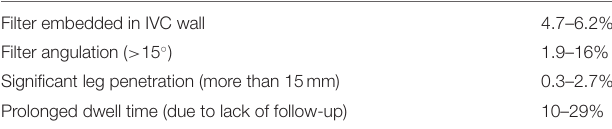
TABLE 2 | Main reasons for standard retrieval technique failure and their overall incidence (40, 45, 53).